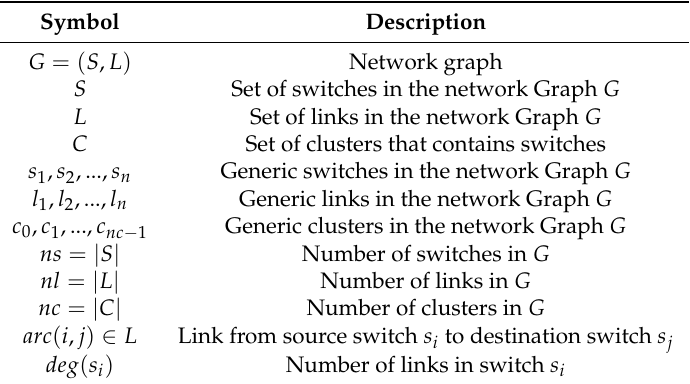
Table 1. Network Notation